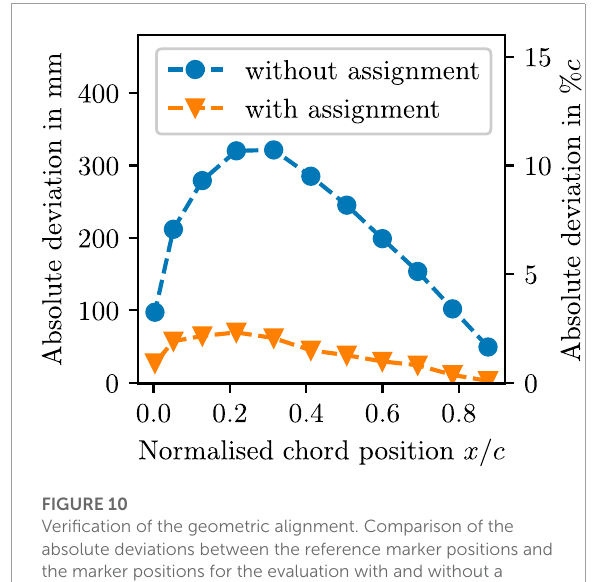
FIGURE 10 Verification of the geometric alignment. Comparison of the absolute deviations between the reference marker positions and the marker positions for the evaluation with and without a geometric assignment. The maximal deviation after geometric assignment is 2.3%c.